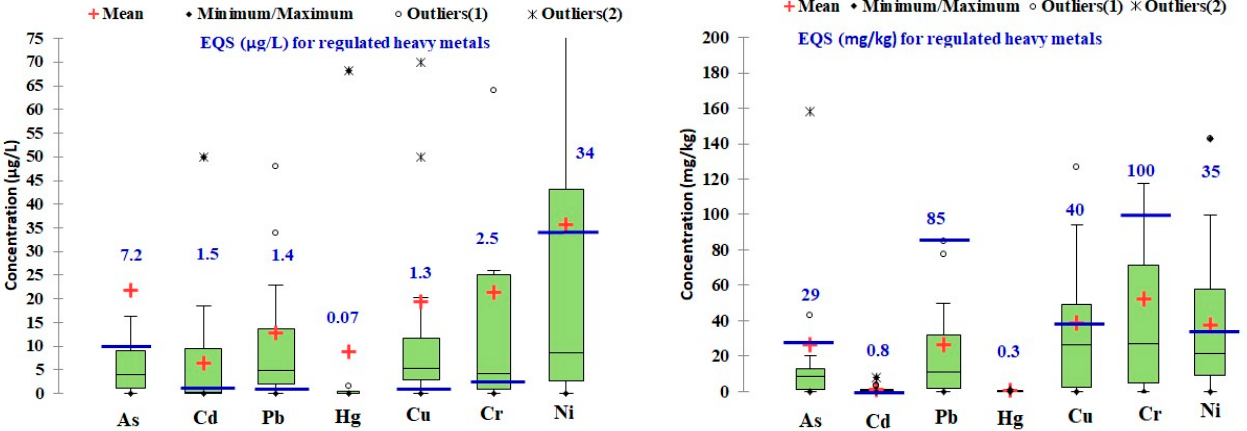
Figure 7. Concentration range of the seven most-reported metals in surface water ( left ) and sediments ( right ) compared to the maximum acceptable concentration (MAC-EQS) according to the Decisions 2013/39/EU and Order 161/2006 (Romanian regulation).